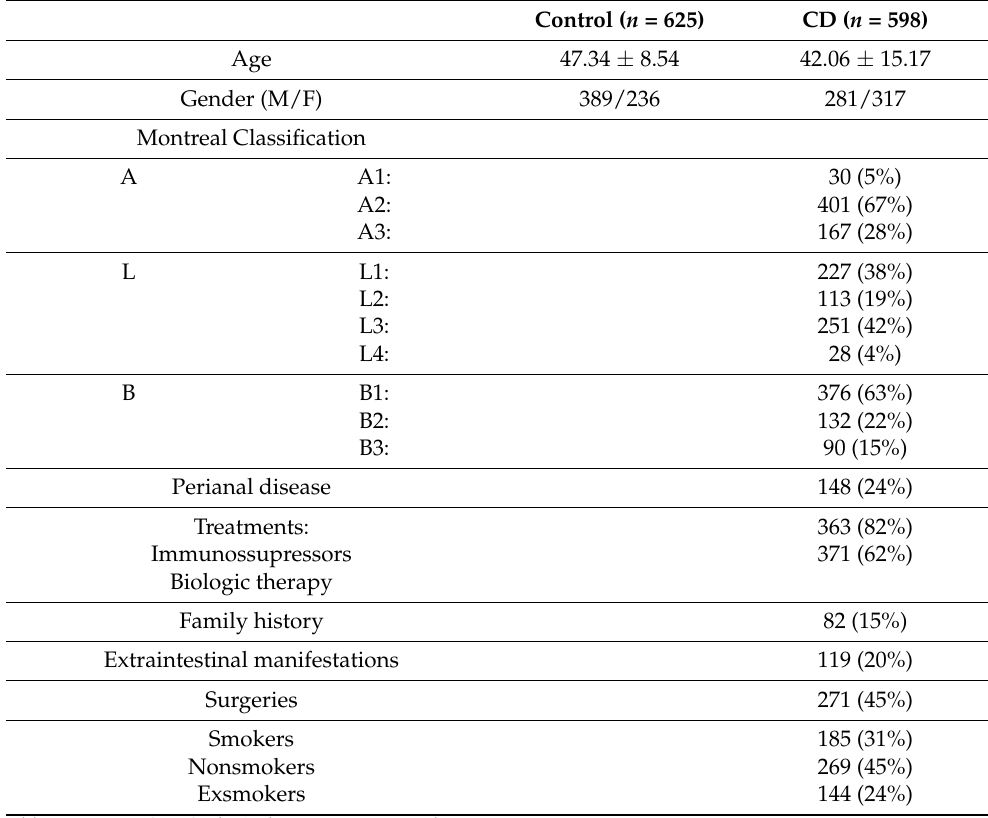
Table 1. Demographic characteristics and clinical data of patients and matched controls.